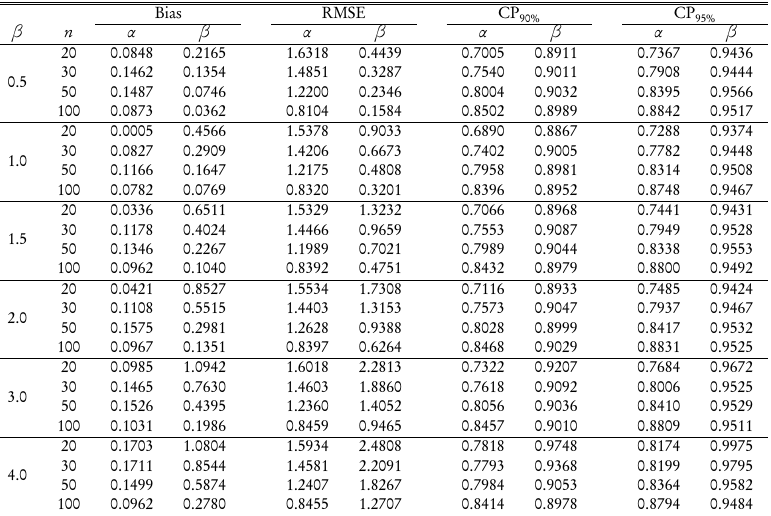
Estimated bias, root mean-squared and coverage probability α and β ( α = 1.5 ).